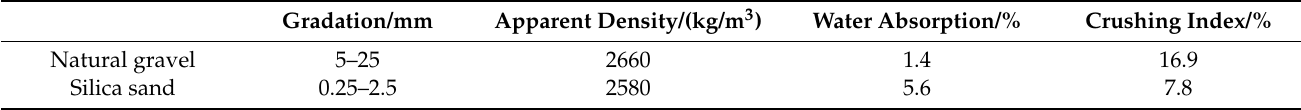
Table 1. Physical properties of natural